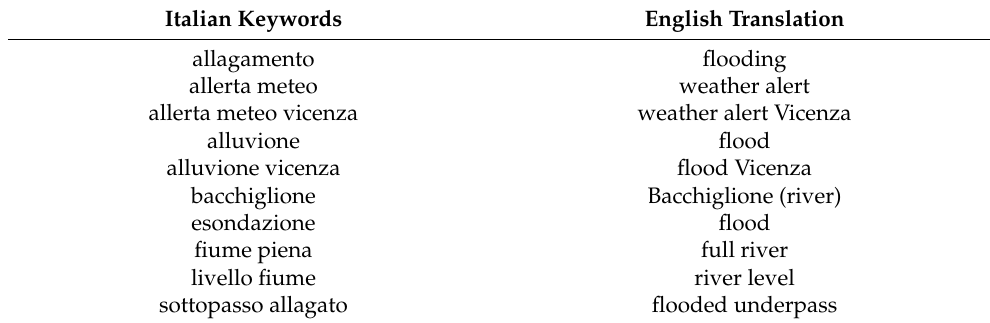
Table 2. Keywords to retrieve tweets.